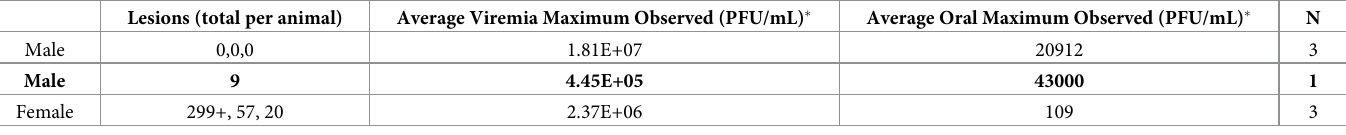
Table 1. Gender comparison of total skin lesion counts, viremia titers, and oral titers. Lesions (total per animal) Average Viremia Maximum Observed (PFU/mL) (cid:3) Average Oral Maximum Observed (PFU/mL)